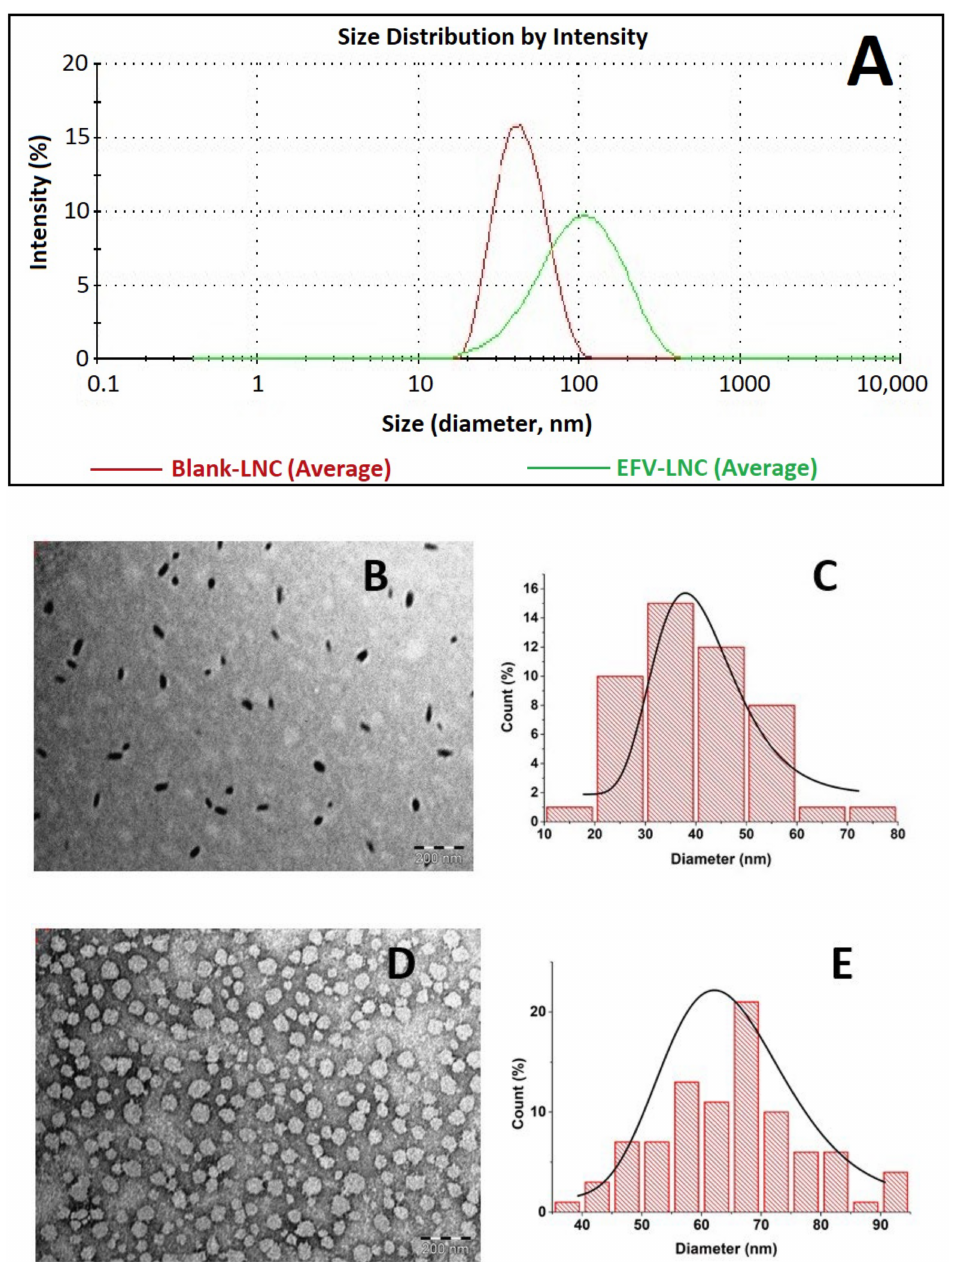
Figure 6. DLS average-particle-size distribution (triplicate) of blank-LNC and EFV-LNC ( A ), TEM images (200 nm scale) of blank-LNC ( B ) and EFV-LNC ( D ), TEM particle-size distribution by ImageJ of blank-LNC ( C ) and EFV-LNC ( E